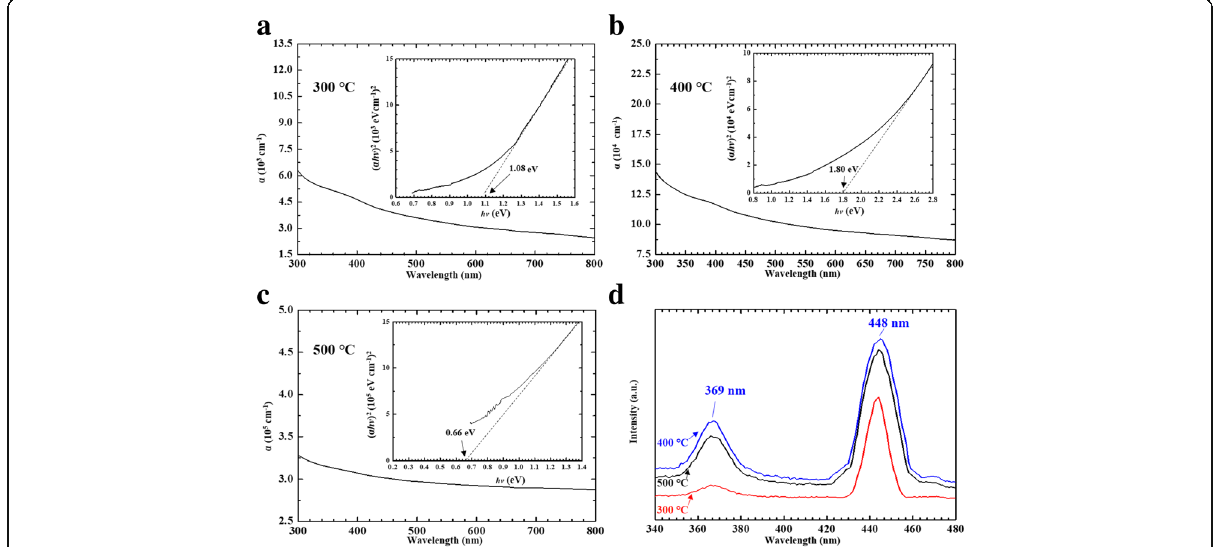
Fig. 4 UV/Visible/NIR absorption spectra and ( α h ν ) 2 versus h ν plot in the insets of figures for synthesizing α -NiS films at a 300, b 400, and c 500 °C. d Fluorescence spectra of the α -NiS films were fabricated at different annealing temperatures (300, 400, and 500 °C for 4